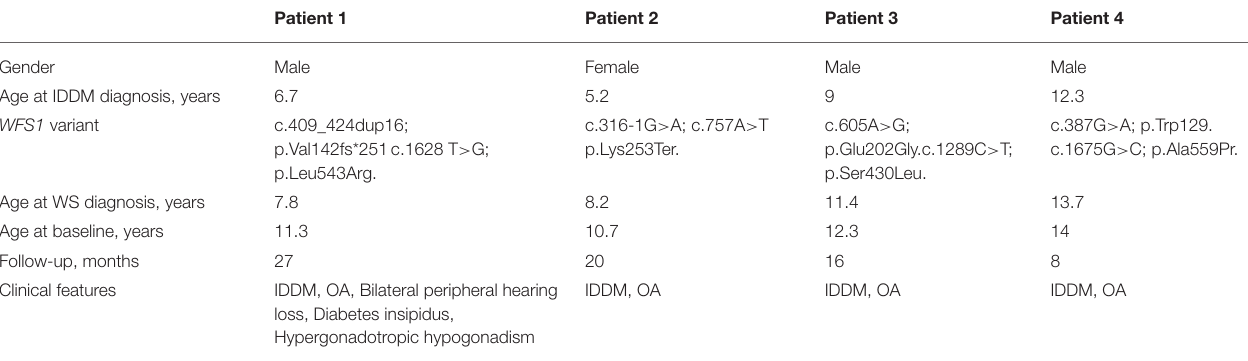
TABLE 1 | Patients’ characteristics.